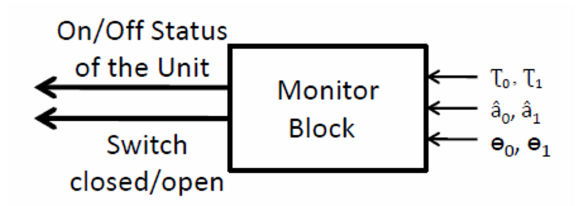
Figure 3. Monitoring block for ECADLL. It receives as inputs the estimations of delay, amplitude and phase, and it controls the powering and insertion of units inside the loop.